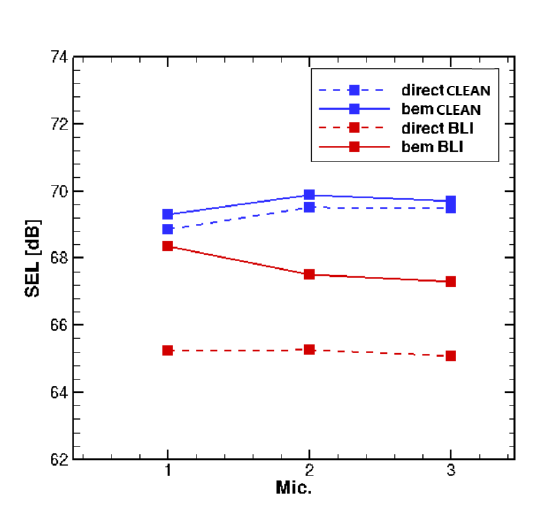
Figure 20. SEL for a single flyover for the three microphones.